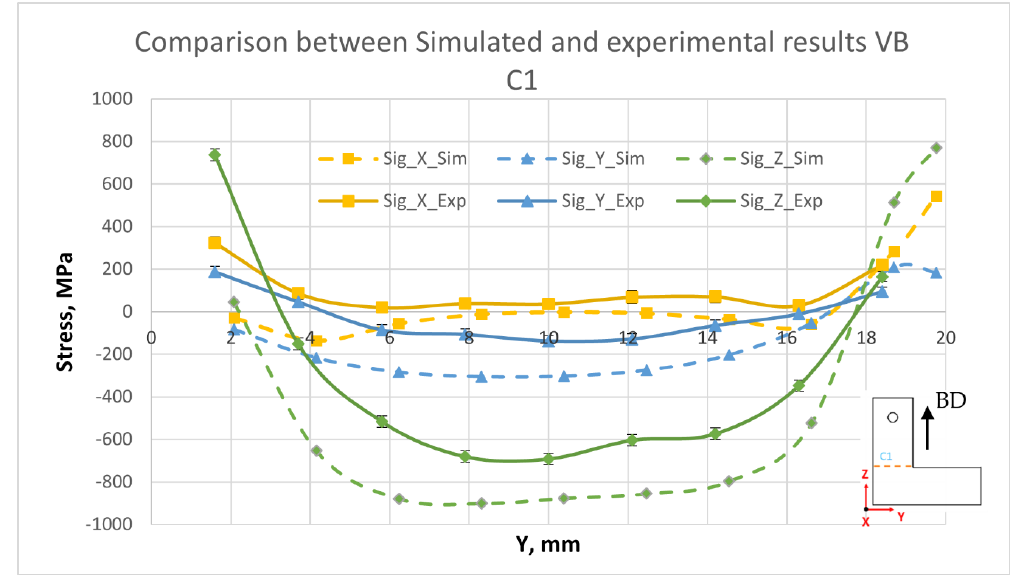
Figure 14. Comparison between experiment and simulation results for VB sample cross-section C1.